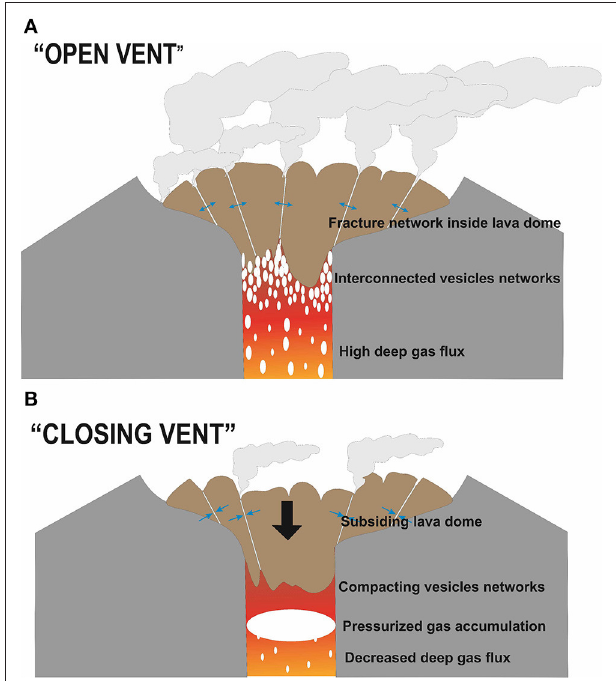
FIGURE 9 | (A,B) Conceptual model of the upper conduit of Popocatépetl volcano (vertical scale not respected). In the deep conduit, the magma is likely fluid enough to support conduit convection ( Witter et al., 2005) and/or bubble flow. In the upper conduit, the rheology is likely too viscous to allow flowing, but a high degree of vesicularity, likely inherited from the vesiculation of the magma at the time of the dome emplacement, allows the gas to flow through a network of interconnected vesicles. In the dome, fractures and tuffisite veins (e.g., Kendrick et al., 2016), also inherited from the dome formation stage, form a permeable network for the gas flow at a shallower